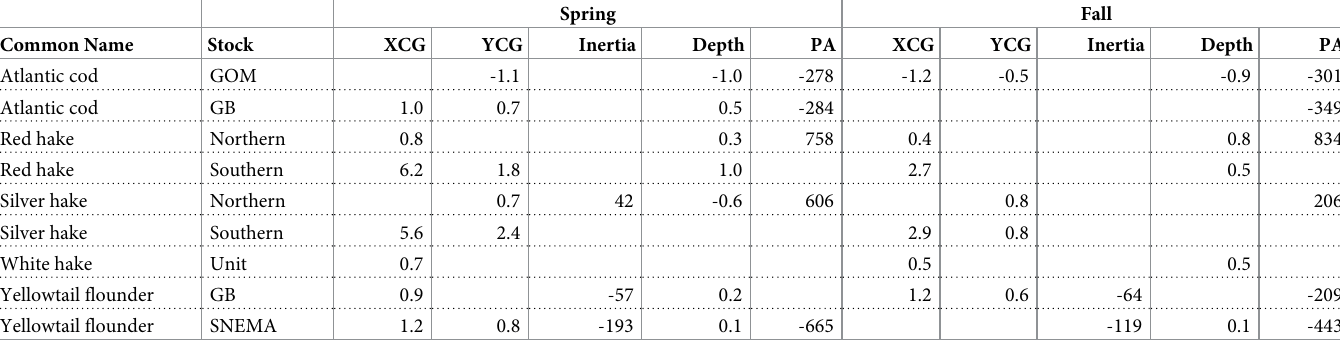
Spatial indicators and associated units are: geographically referenced longitude and latitude of the center of gravity (XCG and YCG, respectively; km), inertia (km 2 ), depth (m) and positive area (PA; km 2 ). Only significant ( p < 0.05) slopes are shown. For brevity, inertia and PA are rounded to the nearest integer. Stock acronyms: